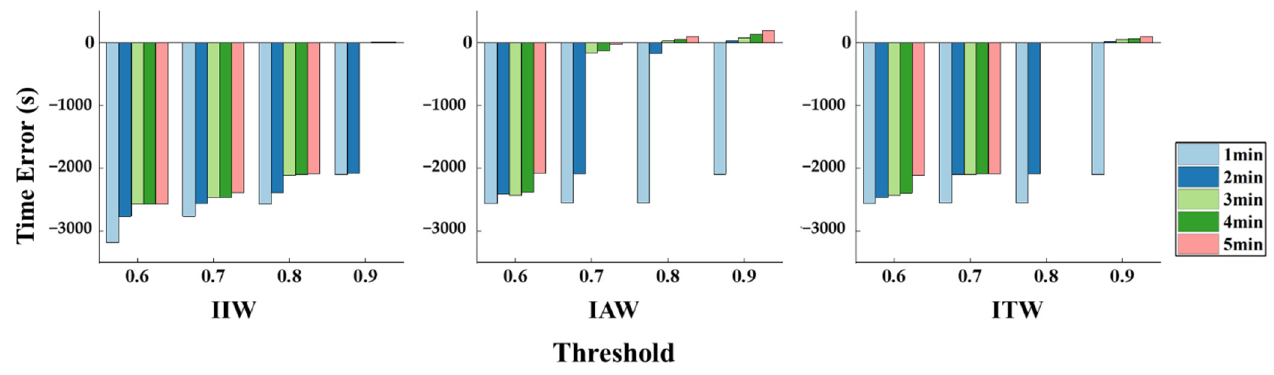
Figure 15. Errors corresponding to the FLI obtained by the di ff erent methods.